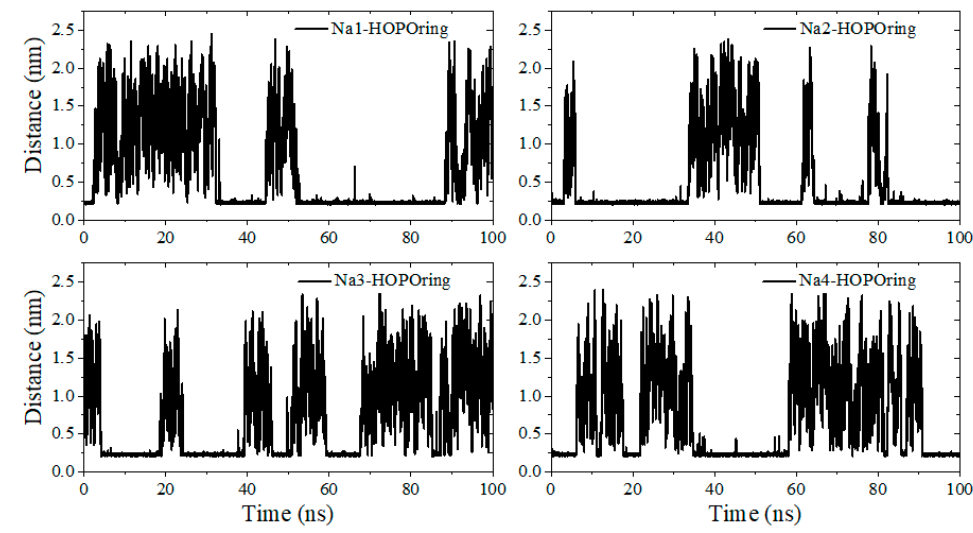
Figure 7. The distances between four Na + ions (Na1, Na2, Na3 and Na4) with the nearest atom of HOPO rings.